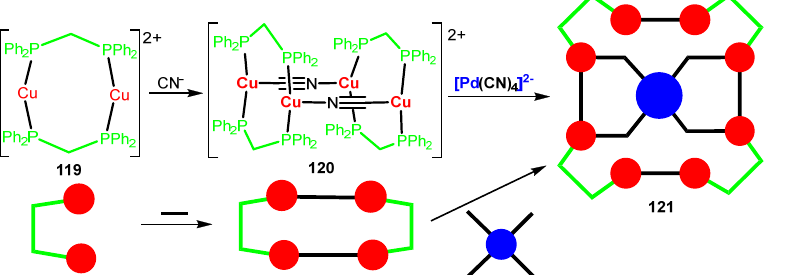
Figure 33. Schematic representation of nonanuclear [Cu 8 Pd(CN) 8 (dppm) 8 ](PF 6 ) 2 complex 121 , built from [Cu 4 (CN) 2 (dppm) 4 ](PF 6 ) 2 120 and K 2 [Pd(CN) 4 ]. Adapted from [109].